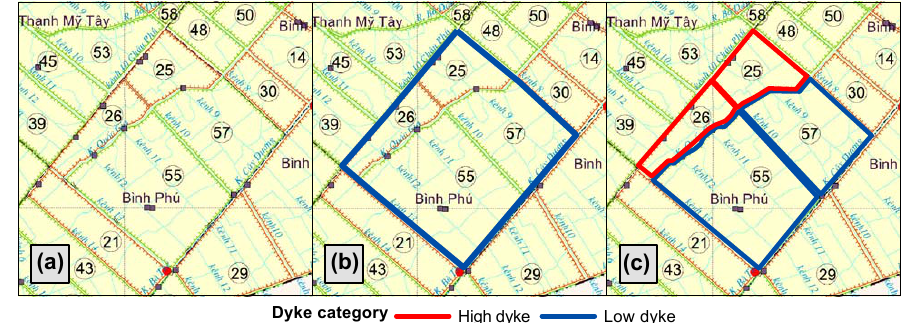
Figure 3. An example of a flood compartment updated in the presented model: (a) dyke survey map: orange lines mean high dykes, green lines represent low dykes, (b) presented as a single compartment in the original model, and (c) updated model river network and dyke system.